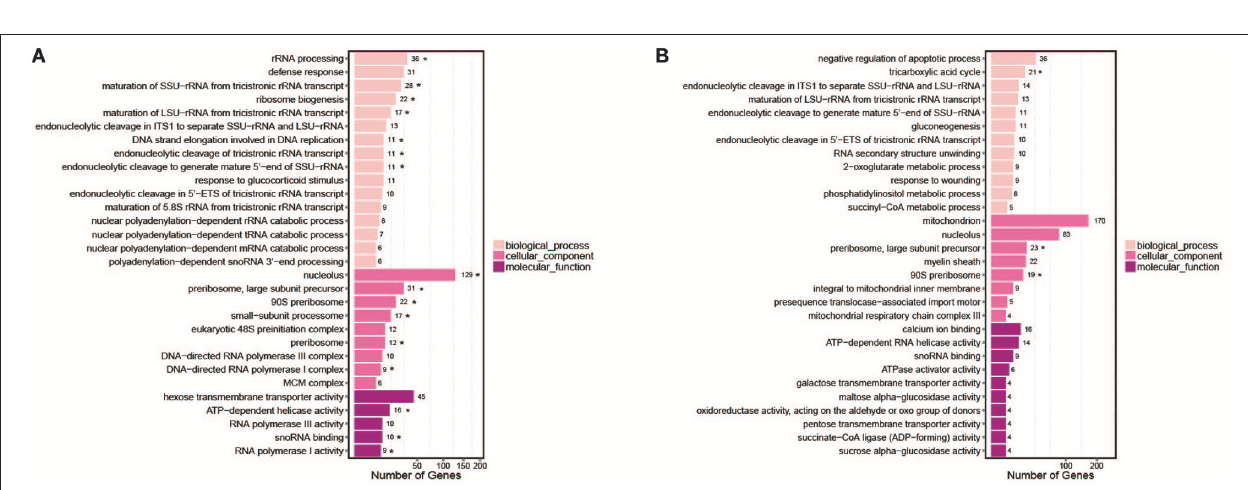
FIGURE 7 | Bar chart of top 30 GO terms for genes with significantly enhanced expression in two endophytic fungi (A) P. polonicum hy4; (B) C. gloeosporioides Cg01. Symbol * indicates enrichment was significant ( Q -value < 0.05). The number after the GO term is the number of genes in the enrichment GO